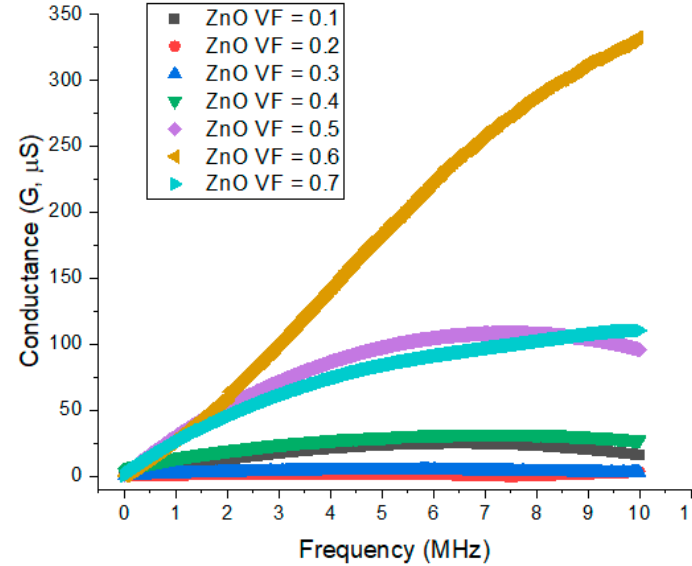
Figure 7. Variation of the Conductance spectrum for the nanocomposite samples for different volume fractions of ZnO with a change of frequency from 20 Hz – 20 MHz.